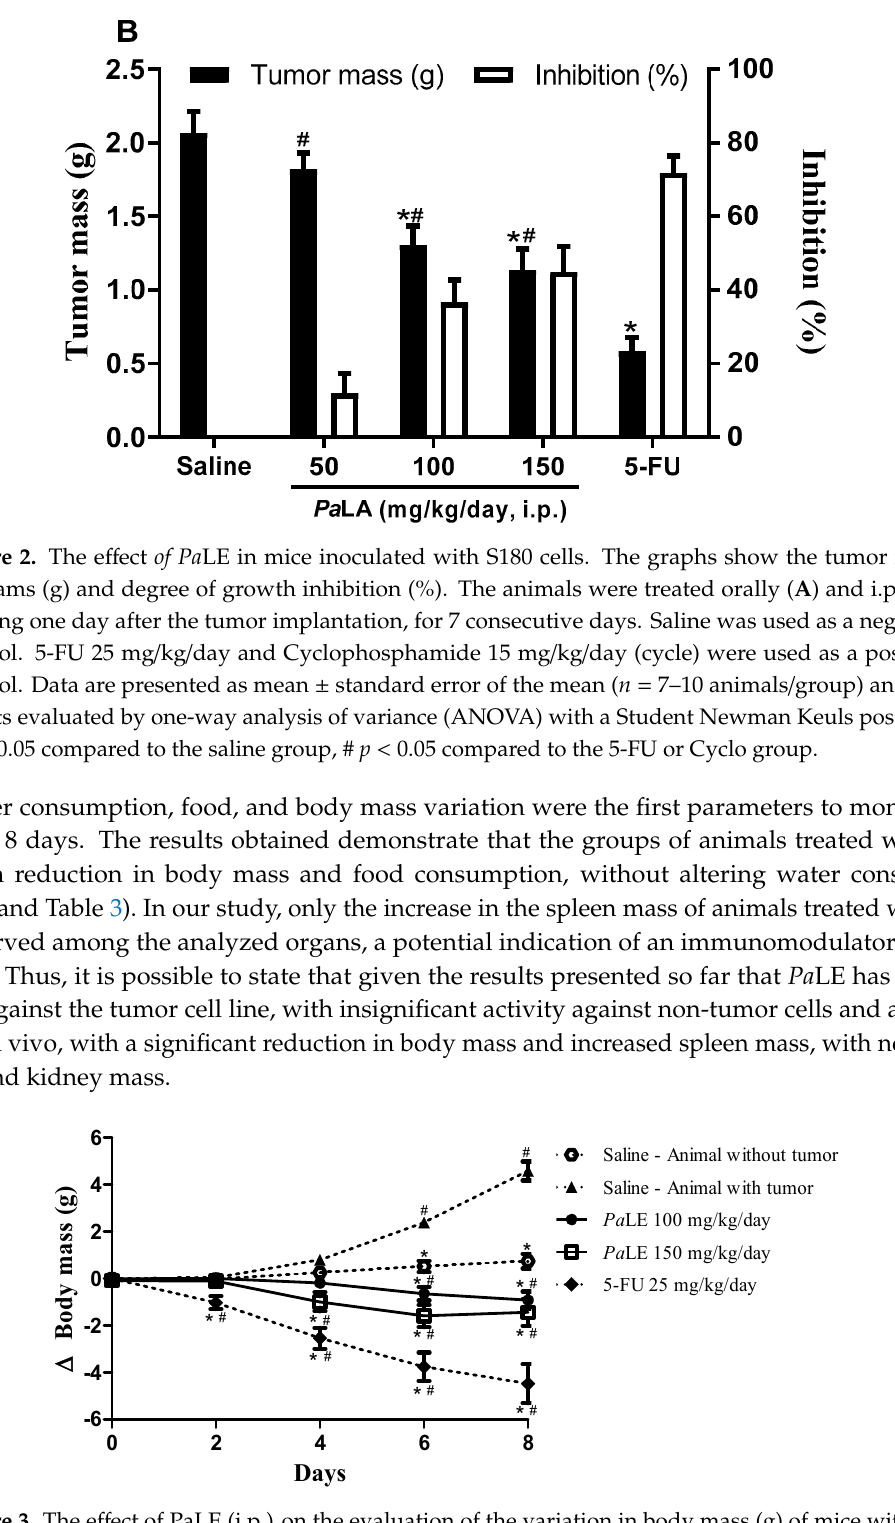
Figure 3. The effect of PaLE (i.p.) on the evaluation of the variation in body mass (g) of mice without and with S180 tumor, for 8 days. Data are presented as the mean ± the standard error of the mean of 10 animals per group. The results were evaluated by two-way ANOVA followed by a Bonferroni post-test. * p < 0.05 compared to the group of animals with the tumor, treated with saline; # p < 0.05 compared to the group of animals without tumor, treated with saline. Saline was used with negative control and 5-FU as the positive